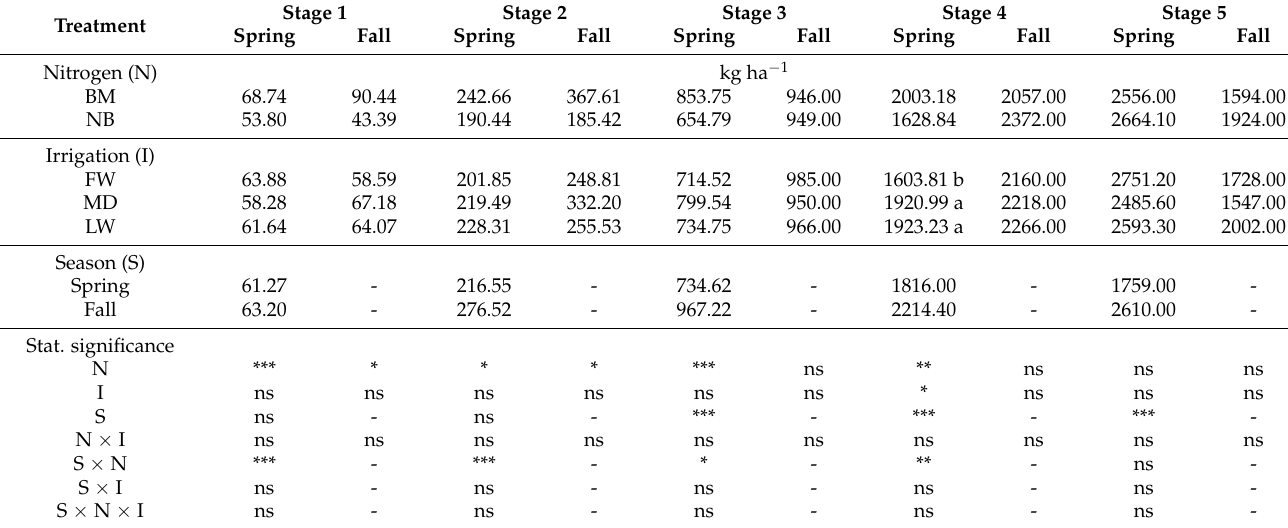
Table 5. Effects of nitrogen (N) and irrigation application timing on tomato growth or biomass accumulation during spring and fall seasons of 2018 in Immokalee, Florida.